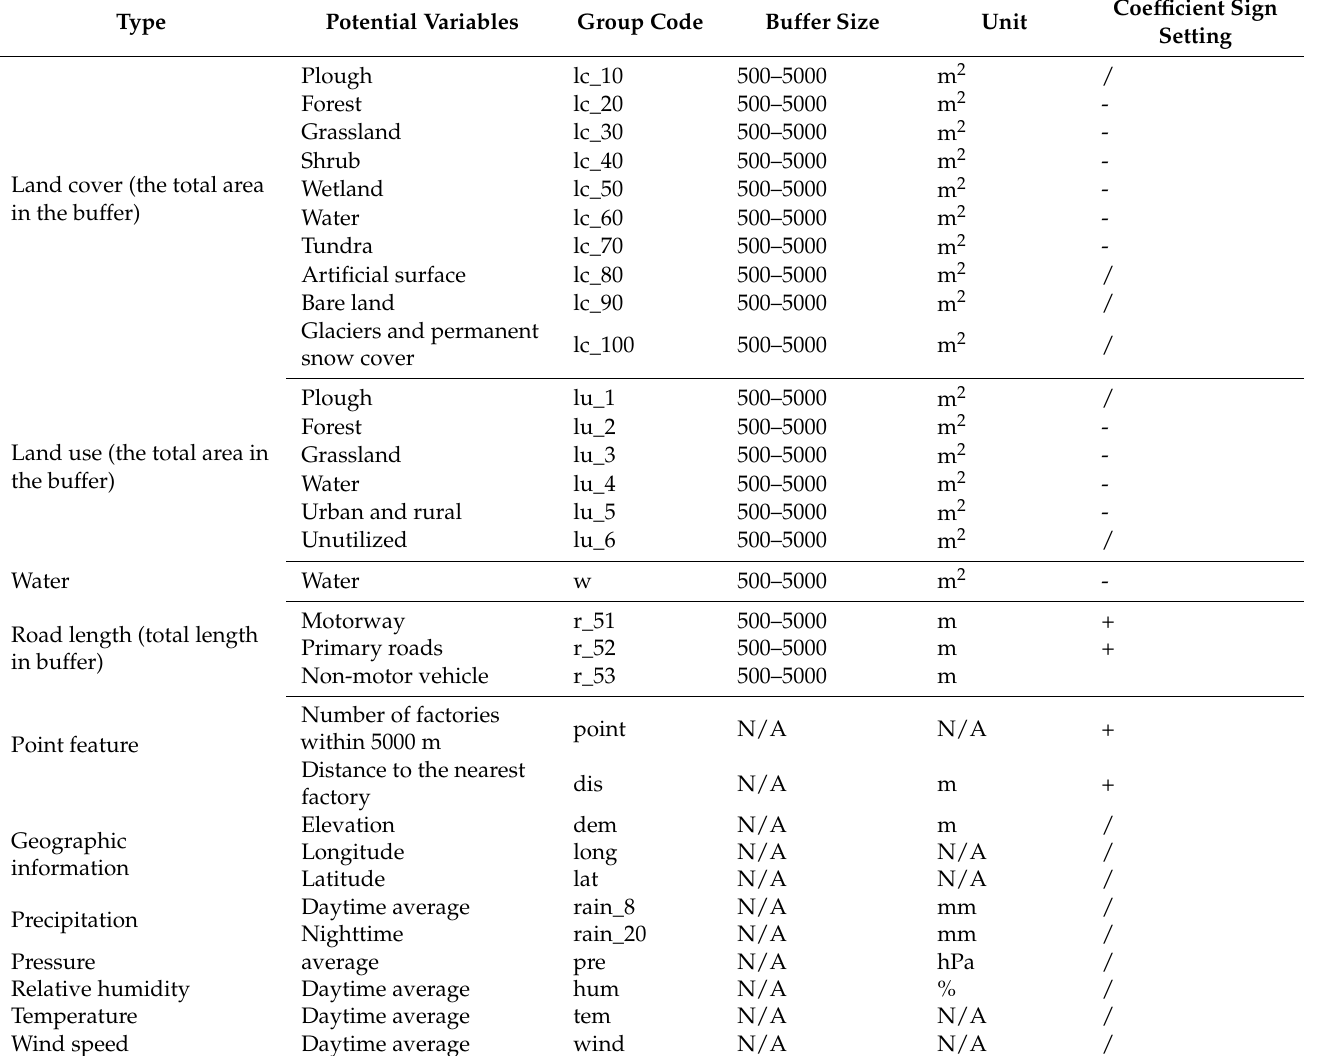
Table 1. Potential variables with units, defined buffer sizes and priority-defined directions of the